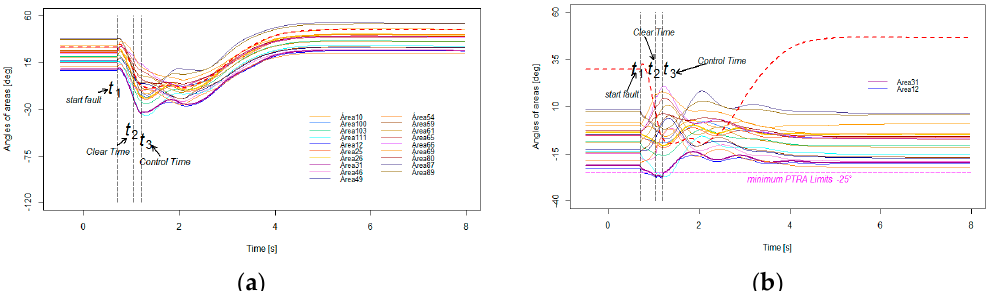
Figure 12. Angles measured in the generation buses of the IEEE 118-bus power system after a three-phase fault in Line 49-66C1 with clearing time at 0.350 ms and control actions such as generation tripping and load shedding. ( a ) Voltage angles and ( b ) relative angles.